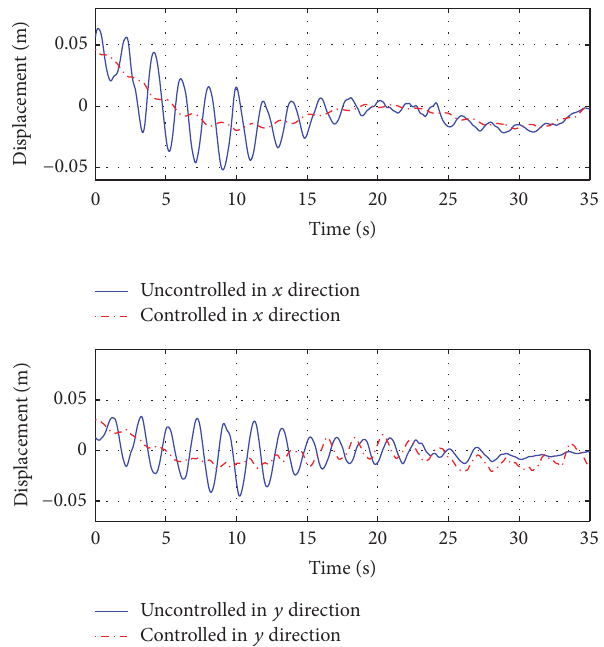
Figure 13: Displacement responses of the tower turret under earthquake.